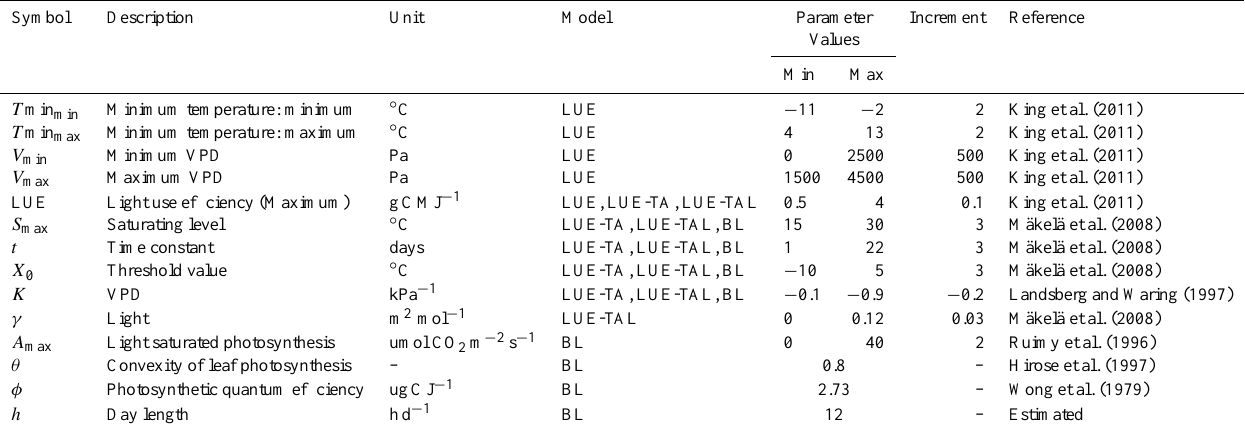
Table 1. Parameters required for LUE, LUE-TA, LUE-TAL and BL models.